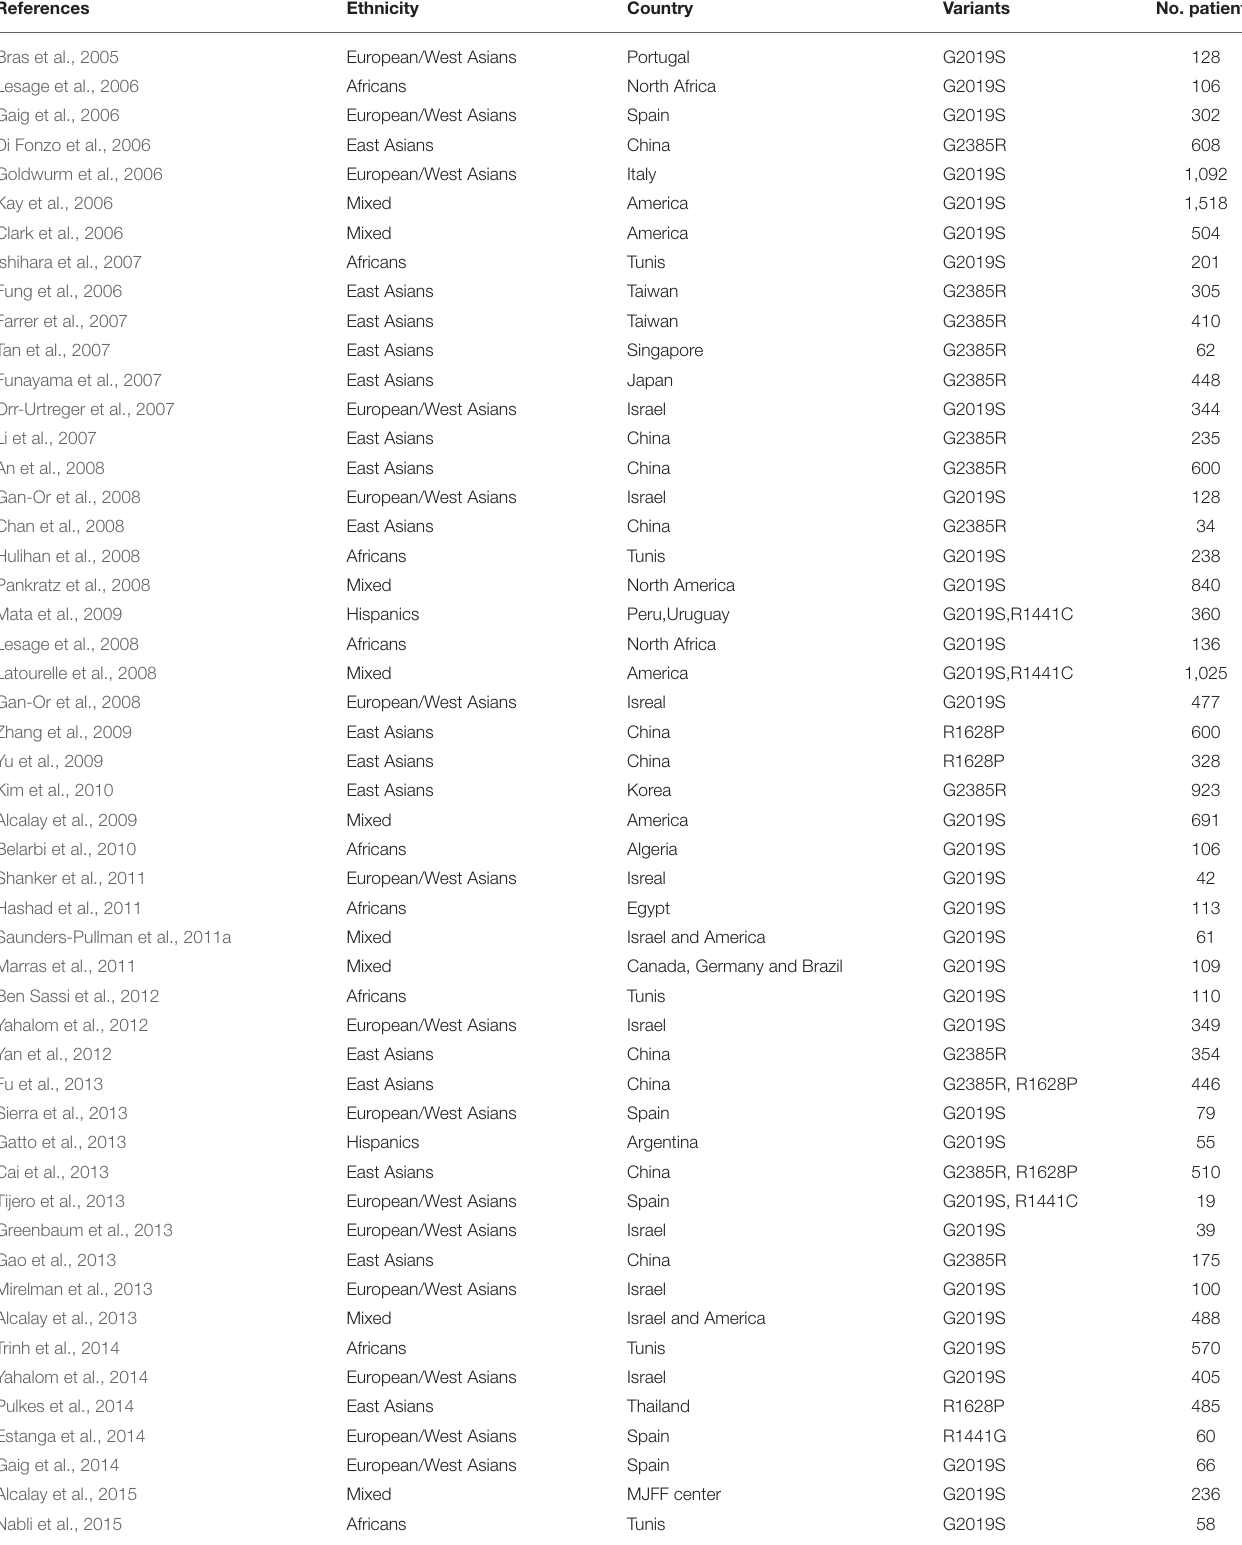
TABLE 1 | The publications included for phenotype